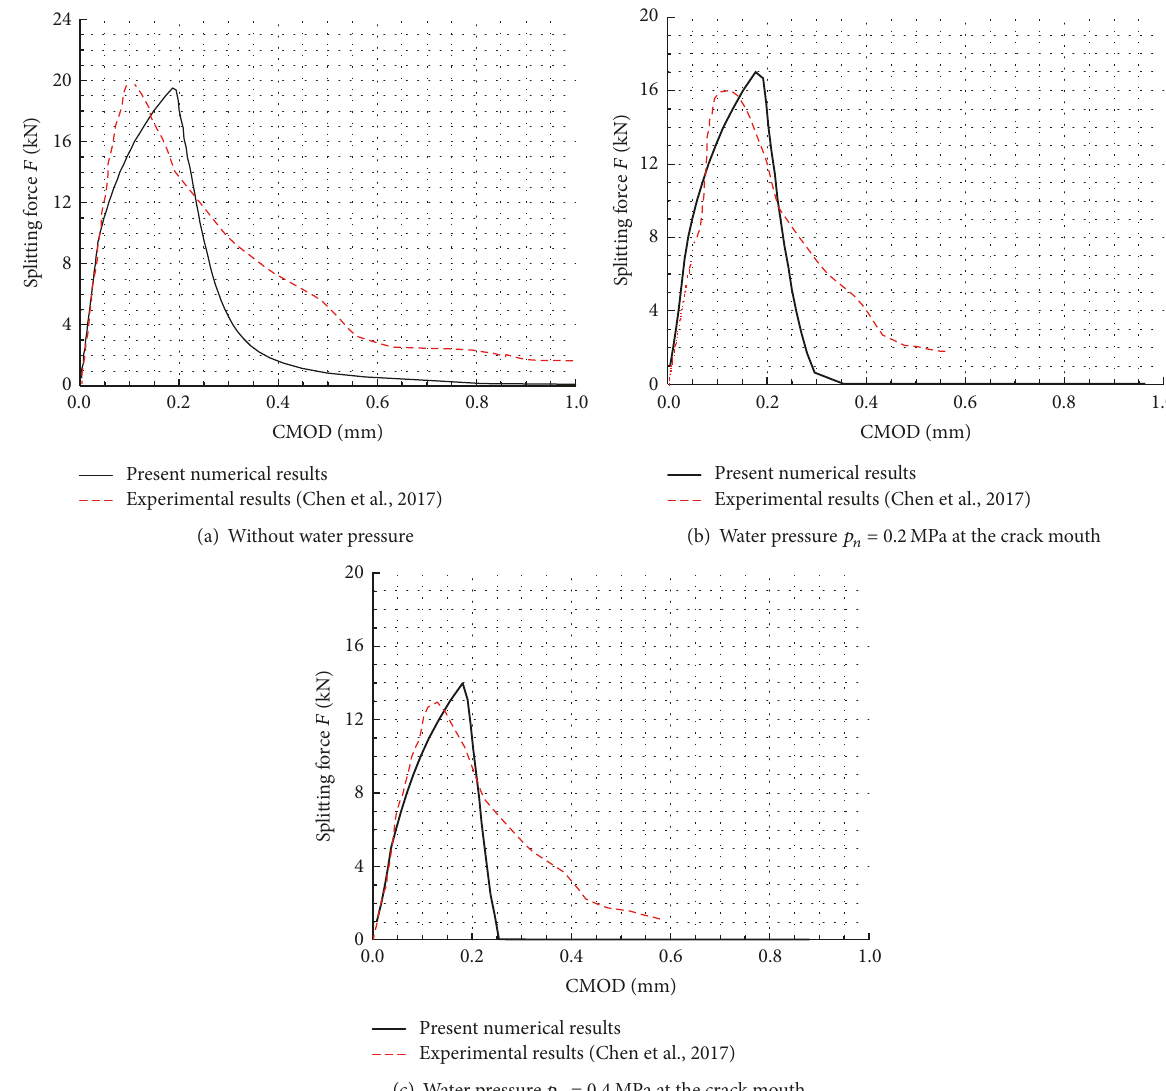
Figure 11: Splitting force vesus CMOD curve for fast loading case with different water